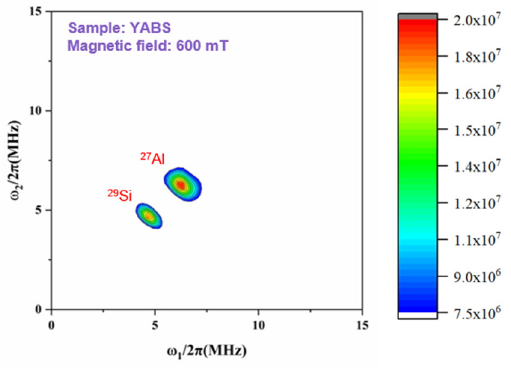
Figure 6. 2D ‐ HYSCORE spectra recorded at a magnetic field of 600 mT for YABS